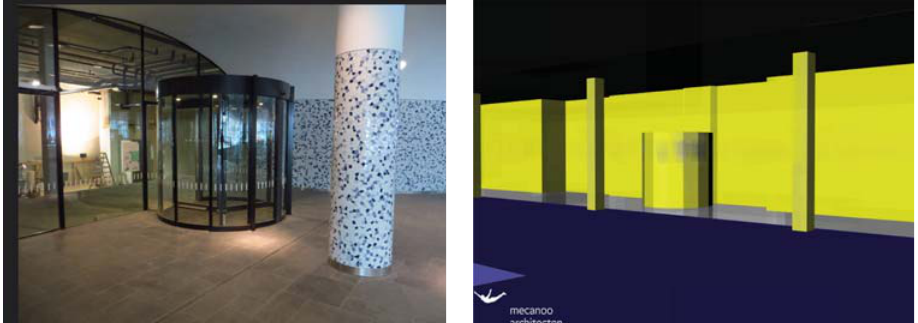
Figure 11. Revolving door of the municipality of Delft extending into the property of another party.